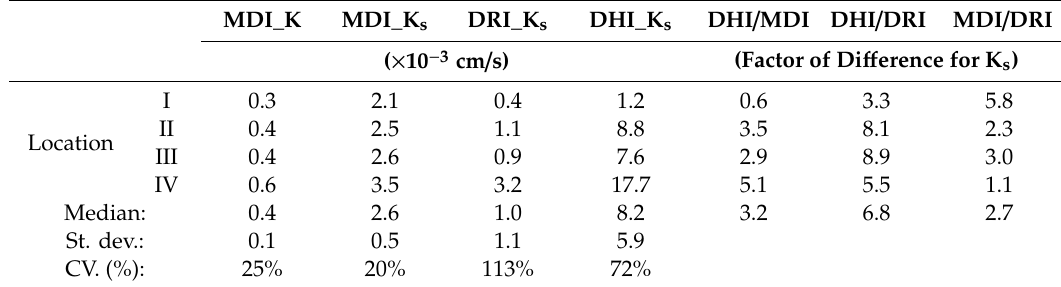
Table 2. Comparison of hydraulic conductivity at measurement locations I –